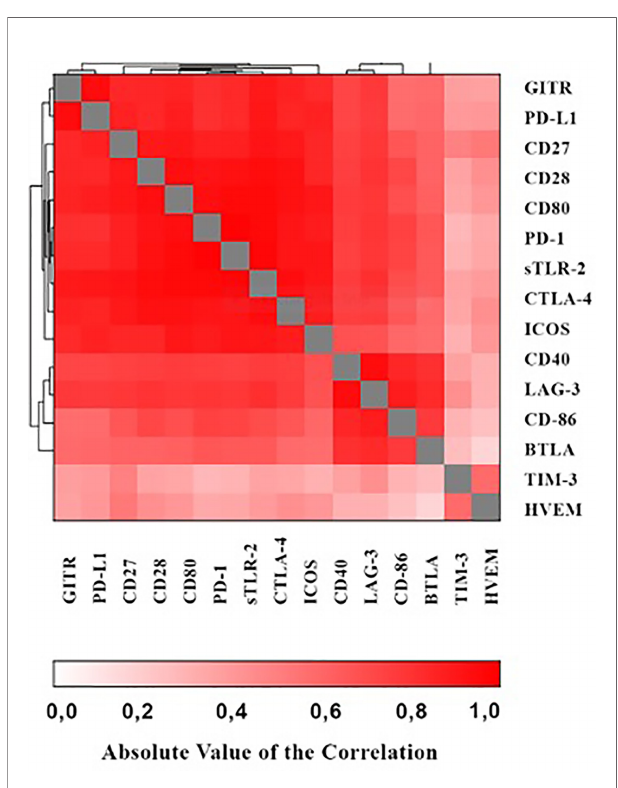
FIGURE 1 | Heat map showing associations of the various immune